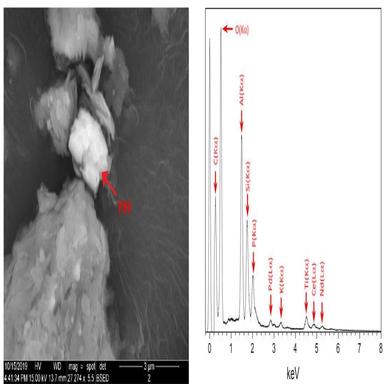
A florencite particle found in the solid residue of SP25-R2.